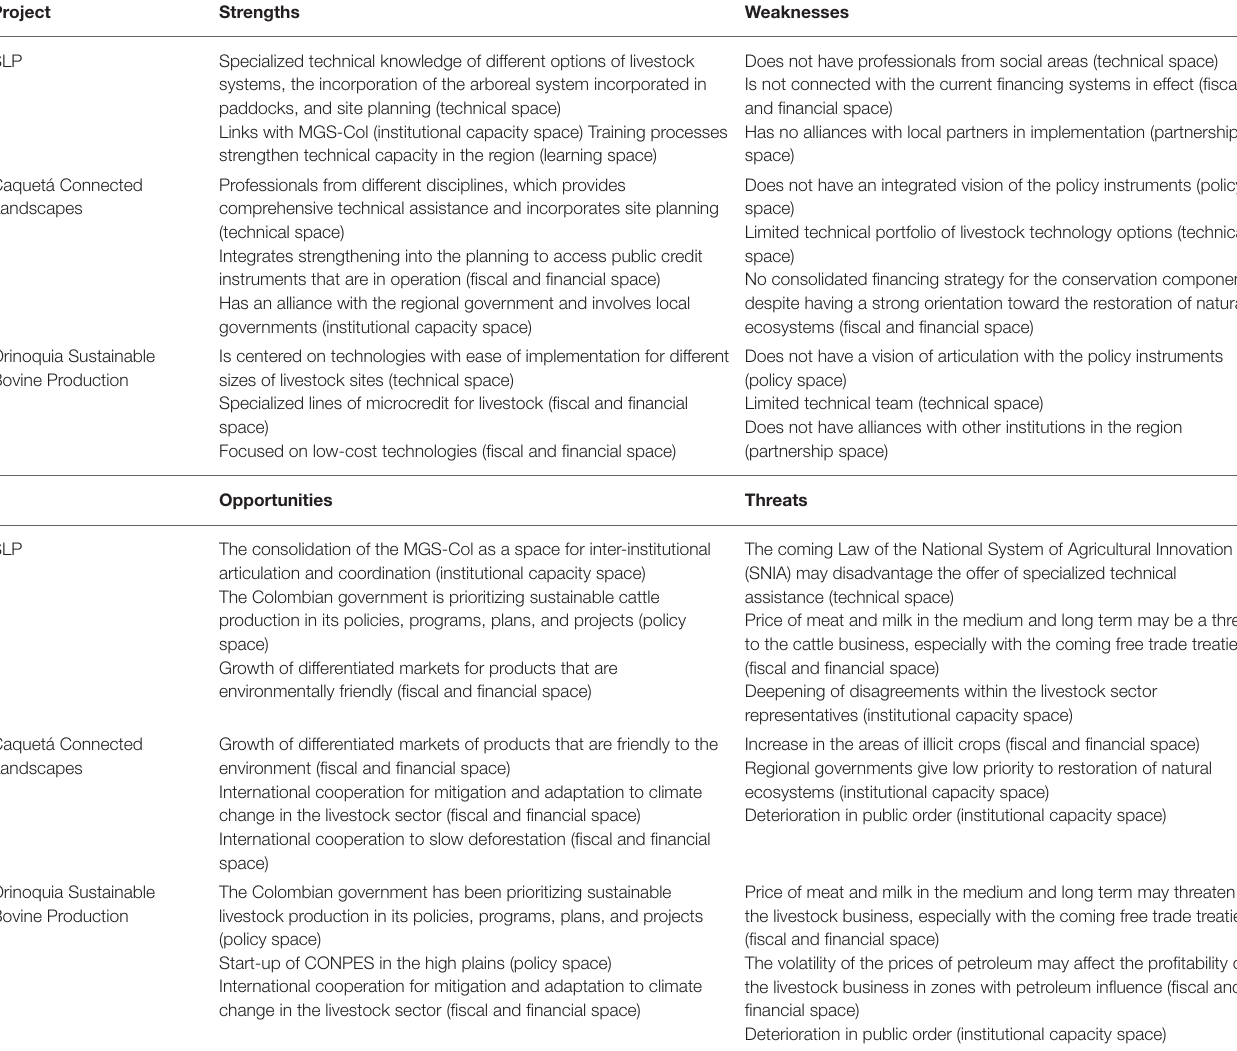
TABLE 4 | SWOT matrix of the selected